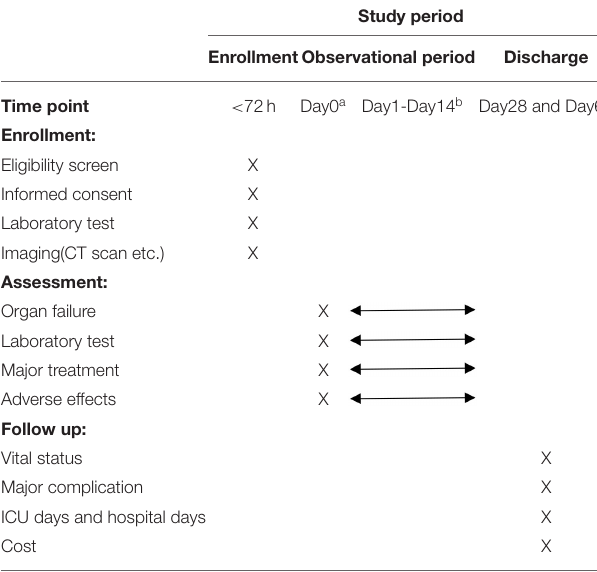
TABLE 1 | Schedule of enrollment, assessment and follow up.